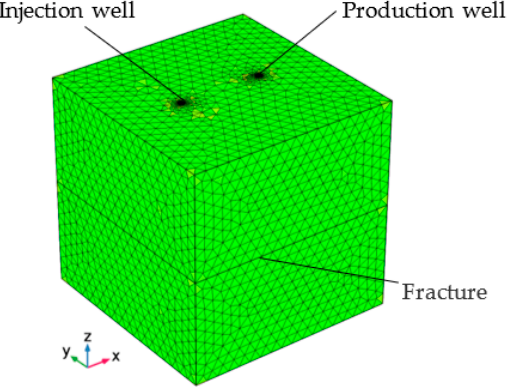
Figure 4. Finite element grid of an enhanced geothermal system.